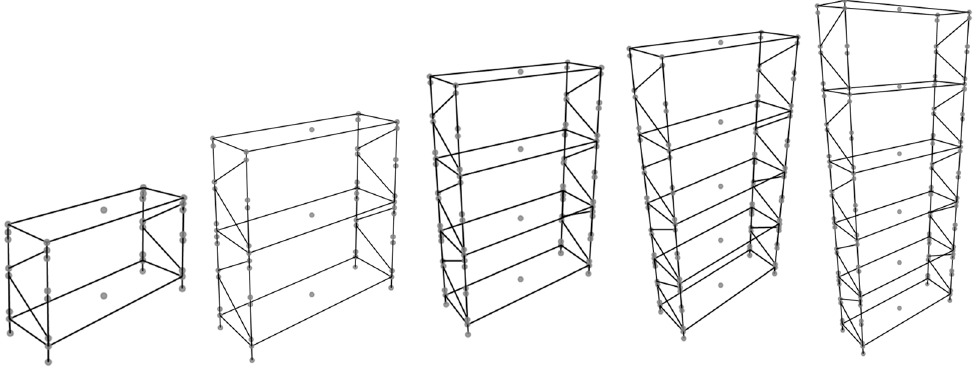
Figure 3. Basic structuring of racks with the different storage levels analyzed (from 2 up to 6).